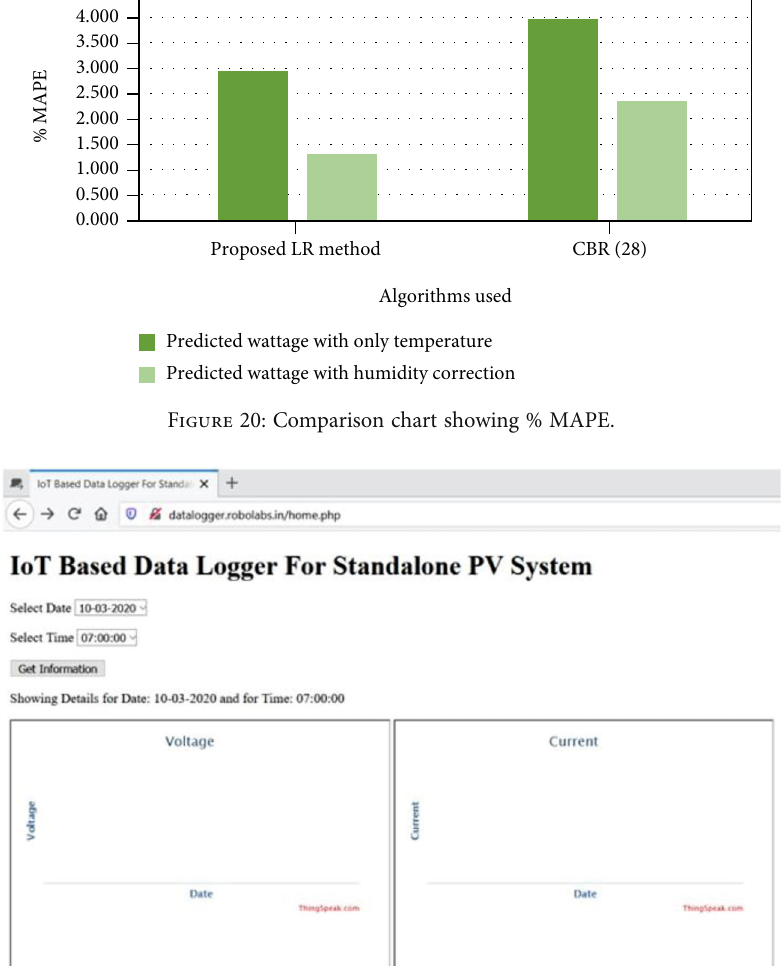
Figure 21: Homepage of developed